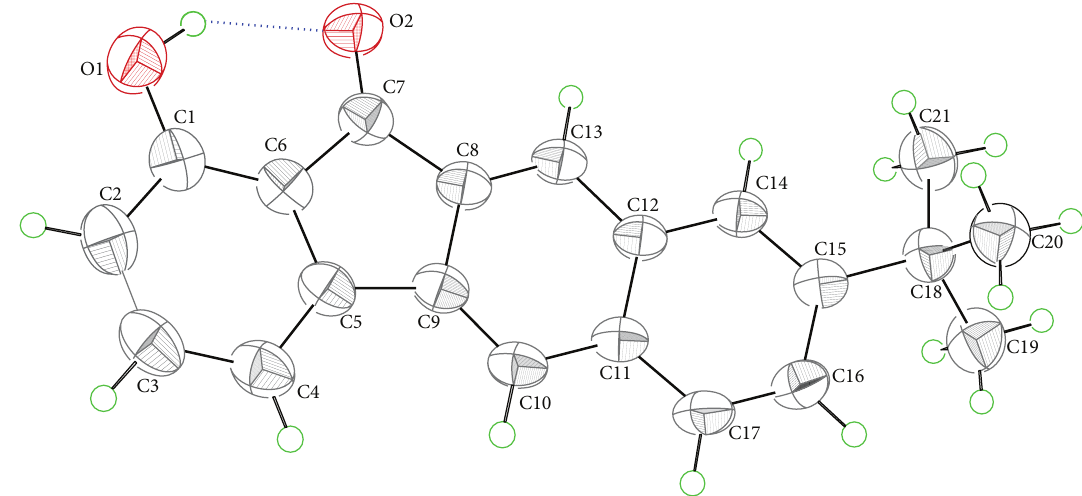
Figure 2: Displacement ellipsoid representation of 1 with the labelling scheme. The ellipsoids are drawn at the 50% probability level and the H atoms are drawn as spheres of arbitrary radii. The blue dashed line denotes the intramolecular hydrogen bond.